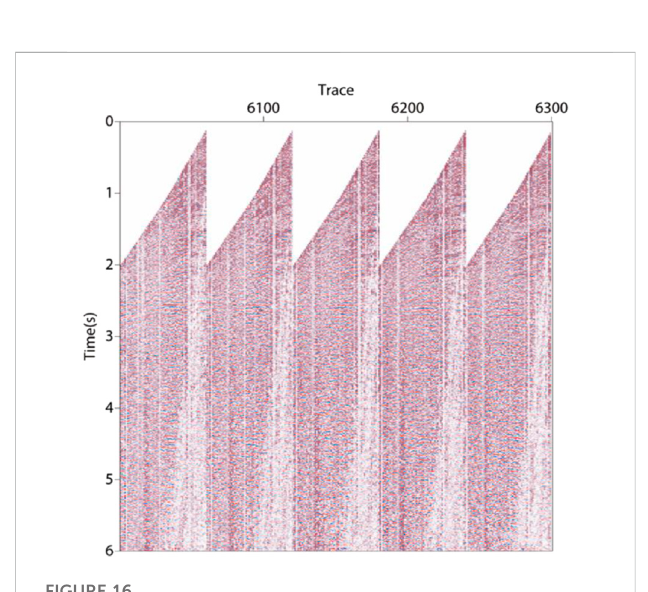
FIGURE 16 100 – 105th shot records extracted from the land fi eld data